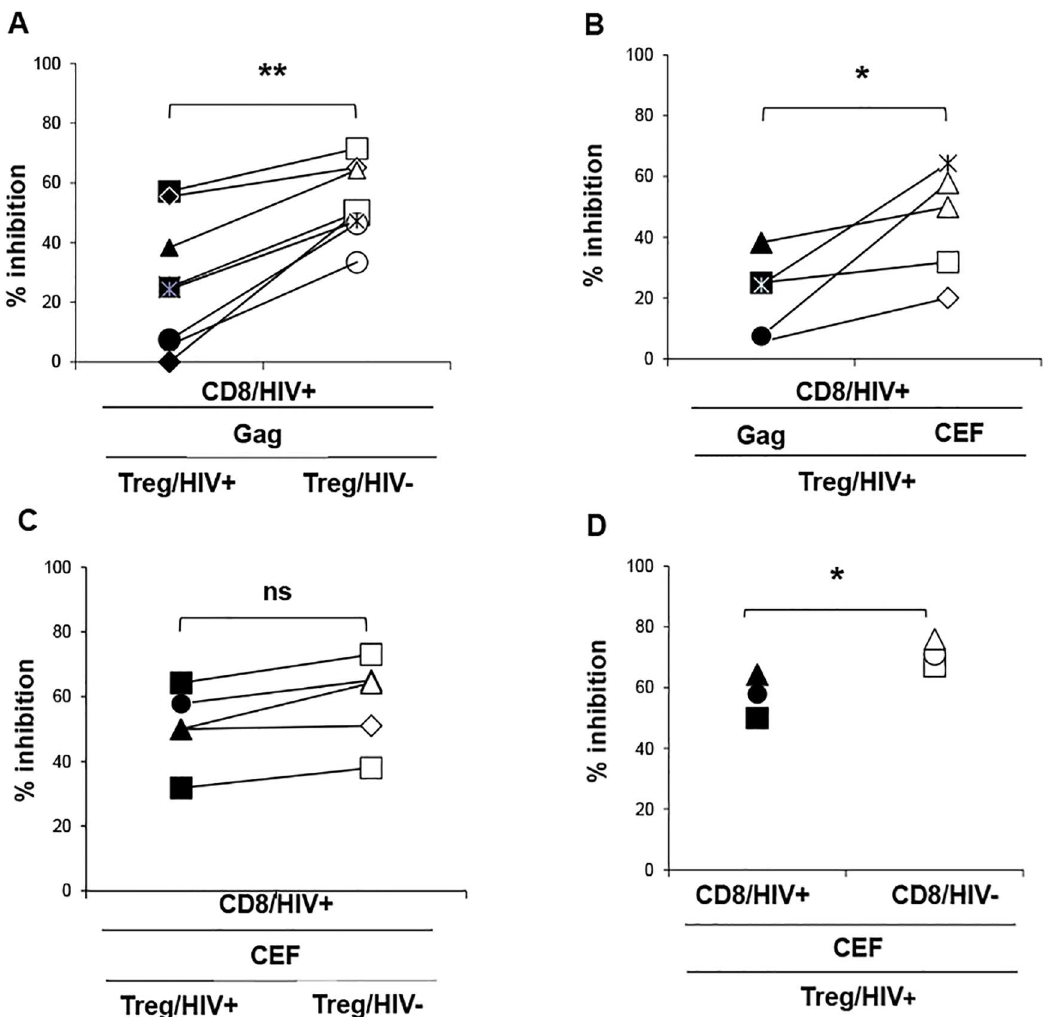
Fig 5. Treg/HIV+ lack suppressive capacity as compared to Treg/HIV- and fail to modulate PD-1/PD-L1 expression on HIV-specific CD8 T cells. Individual data from co-culture and cross-culture studies comparing the inhibitionof IFN γ expression by A. Gag-stimulated HIV+ CD8 T cells in the presence of autologous (left) or HIV- (right) CD4+CD25 high T cells, (n = 8). B. Gag-stimulated (left) and CEF-stimulated (right) HIV+ CD8 T cells in the presence of autologous CD4+CD25 high T cells, (n = 5). C . CEF-stimulated HIV+ CD8 T cells in the presence of autologous (left) or HIV- (right) CD4+CD25 high T cells, (n = 5). D. CEF-stimulated autologousco-cultures and cross-cultures in which